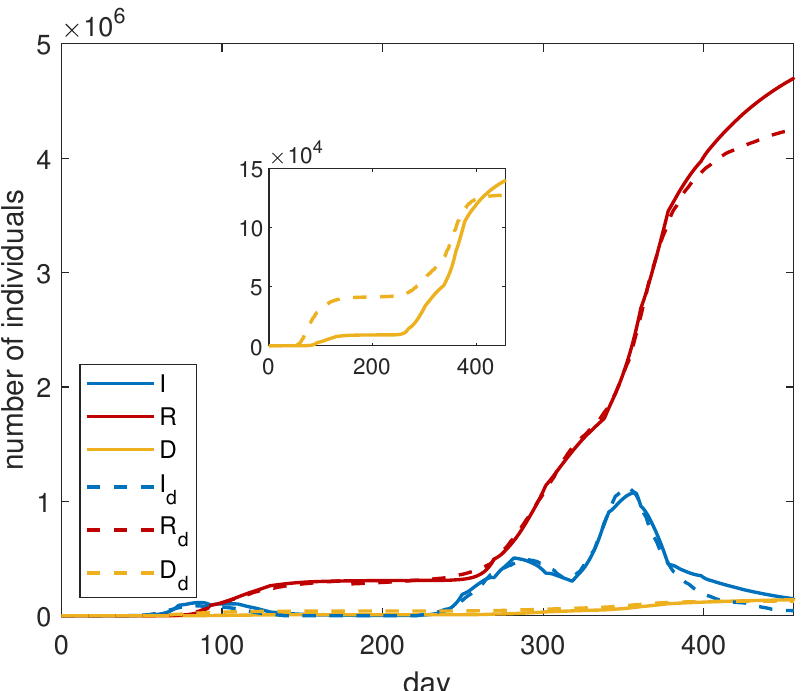
Figure 5. Comparison between SIRD model (3) with parameters of Table 4 (continuous lines) and GBR data (dashed lines). In the inset, the curve of the deaths is magnified.